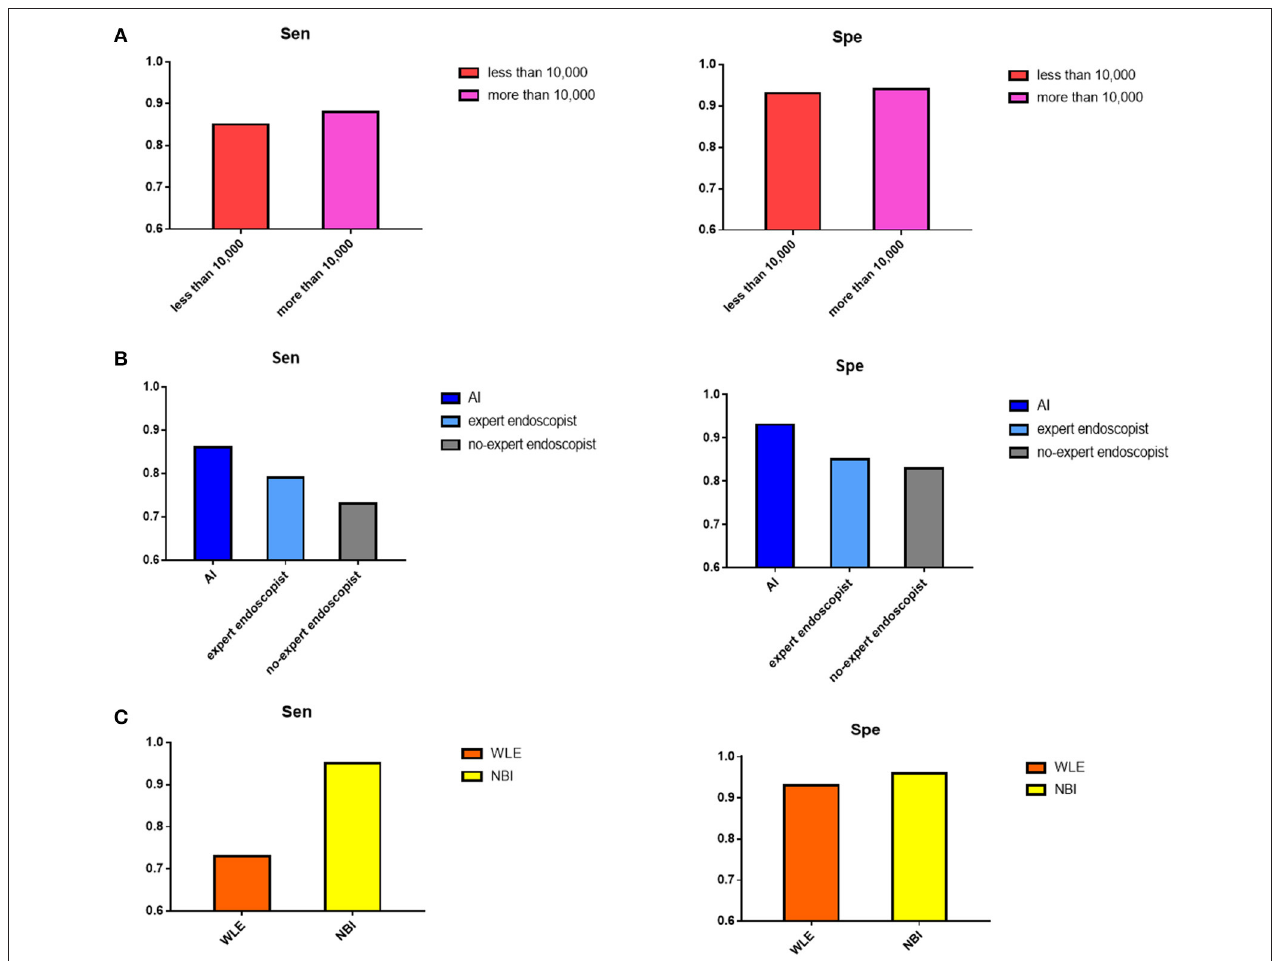
FIGURE 5 | Result of subgroup analysis. (A) The pooled sensitivity and specificity of number of images in training process showed when the images were more than 10,000, the diagnostic value would be better. (B) The pooled sensitivity and specificity of AI detection, expert endoscopist, and non-expert endoscopist showed AI detection and expert endoscopist judgement were significantly more accurate than non-expert endoscopist. (C) The pooled sensitivity and specificity of original images extracted by NBI and WLE showed NBI image applied performed